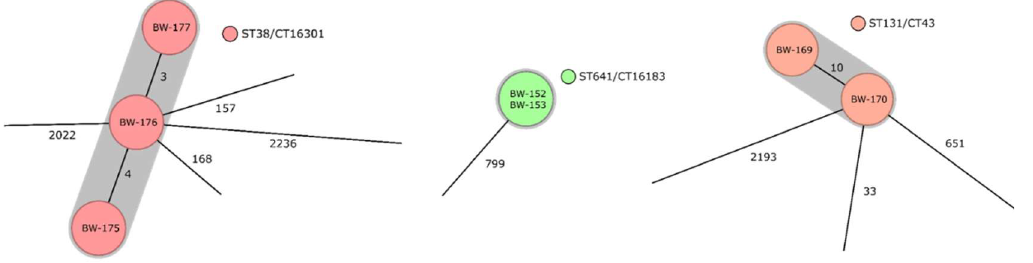
Figure 1. Observed clusters of closely related isolates. Numbers between the nodes indicate allele differences of the cgMLST analysis between the different samples.